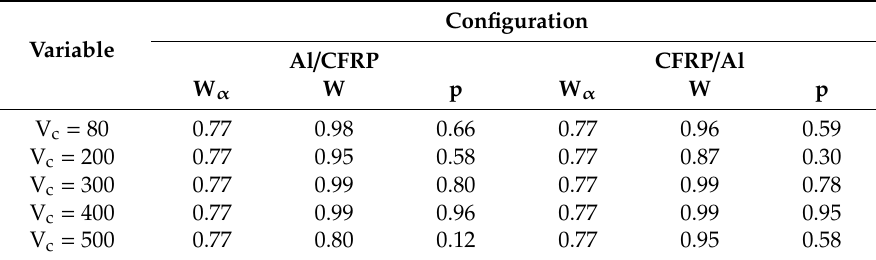
Table 5. Shapiro-Wilk test results for V c variable [27].